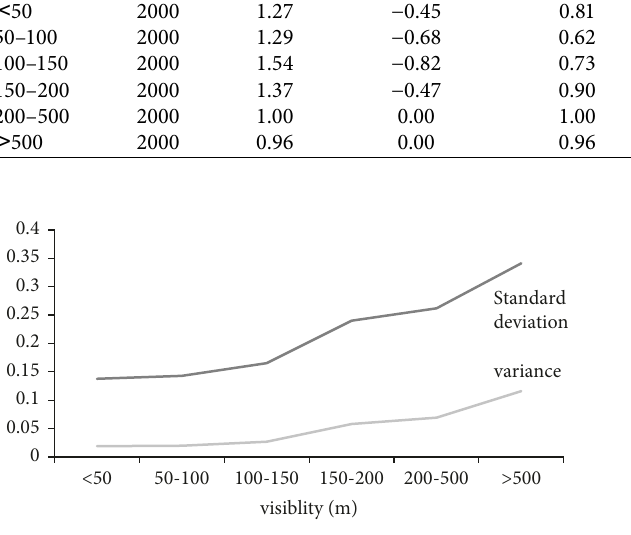
Figure 2: Curve on the difference of the center of gravity of the driver’s gaze under low visibility.